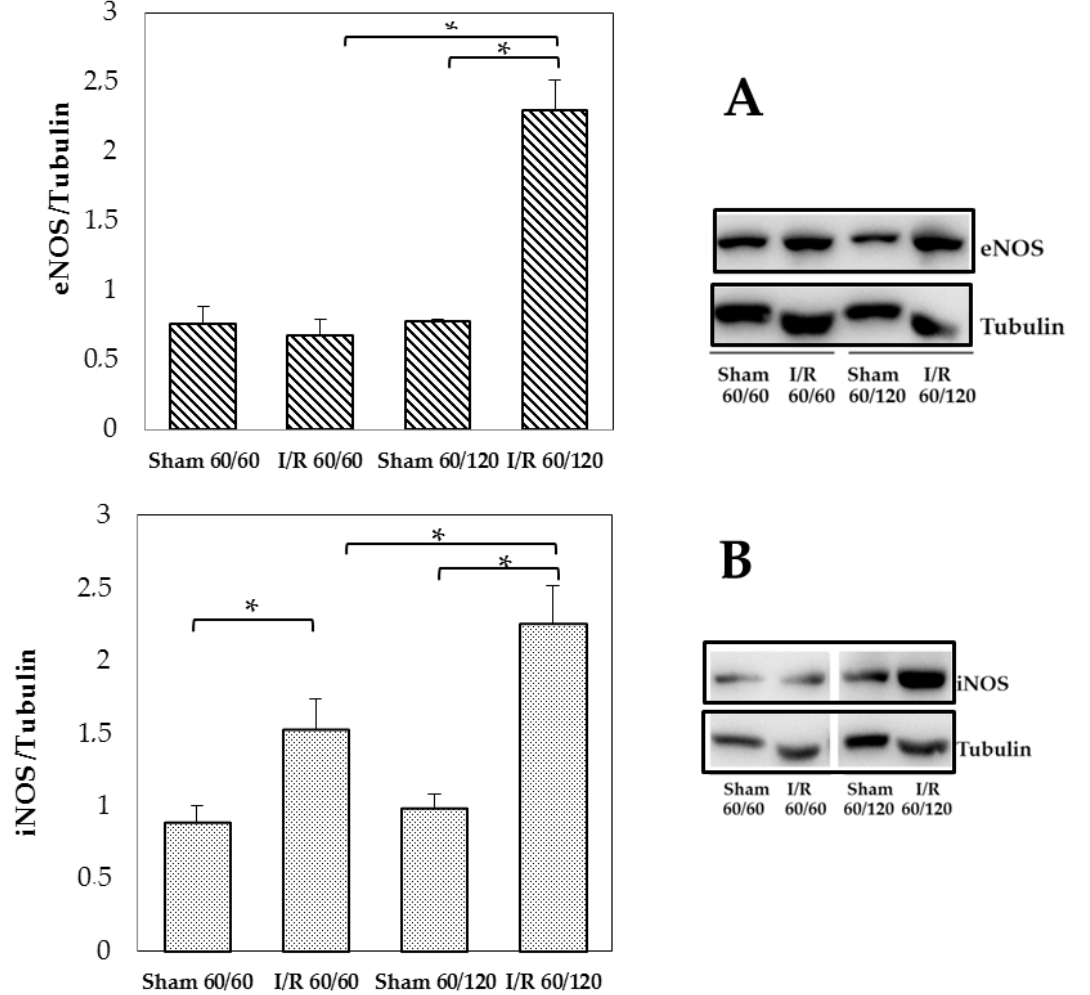
Figure 4. Hepatic eNOS and iNOS at the end of reperfusion. Panel ( A ): eNOS, * p = 0.002; Panel ( B ): iNOS, * p = 0.004. The results are reported as the mean ± SE of 6 different experiments.